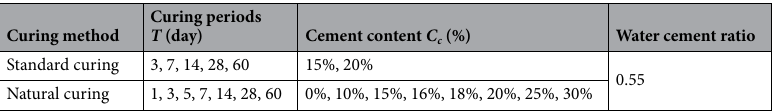
Table 3. Details of specimens in laboratory test.